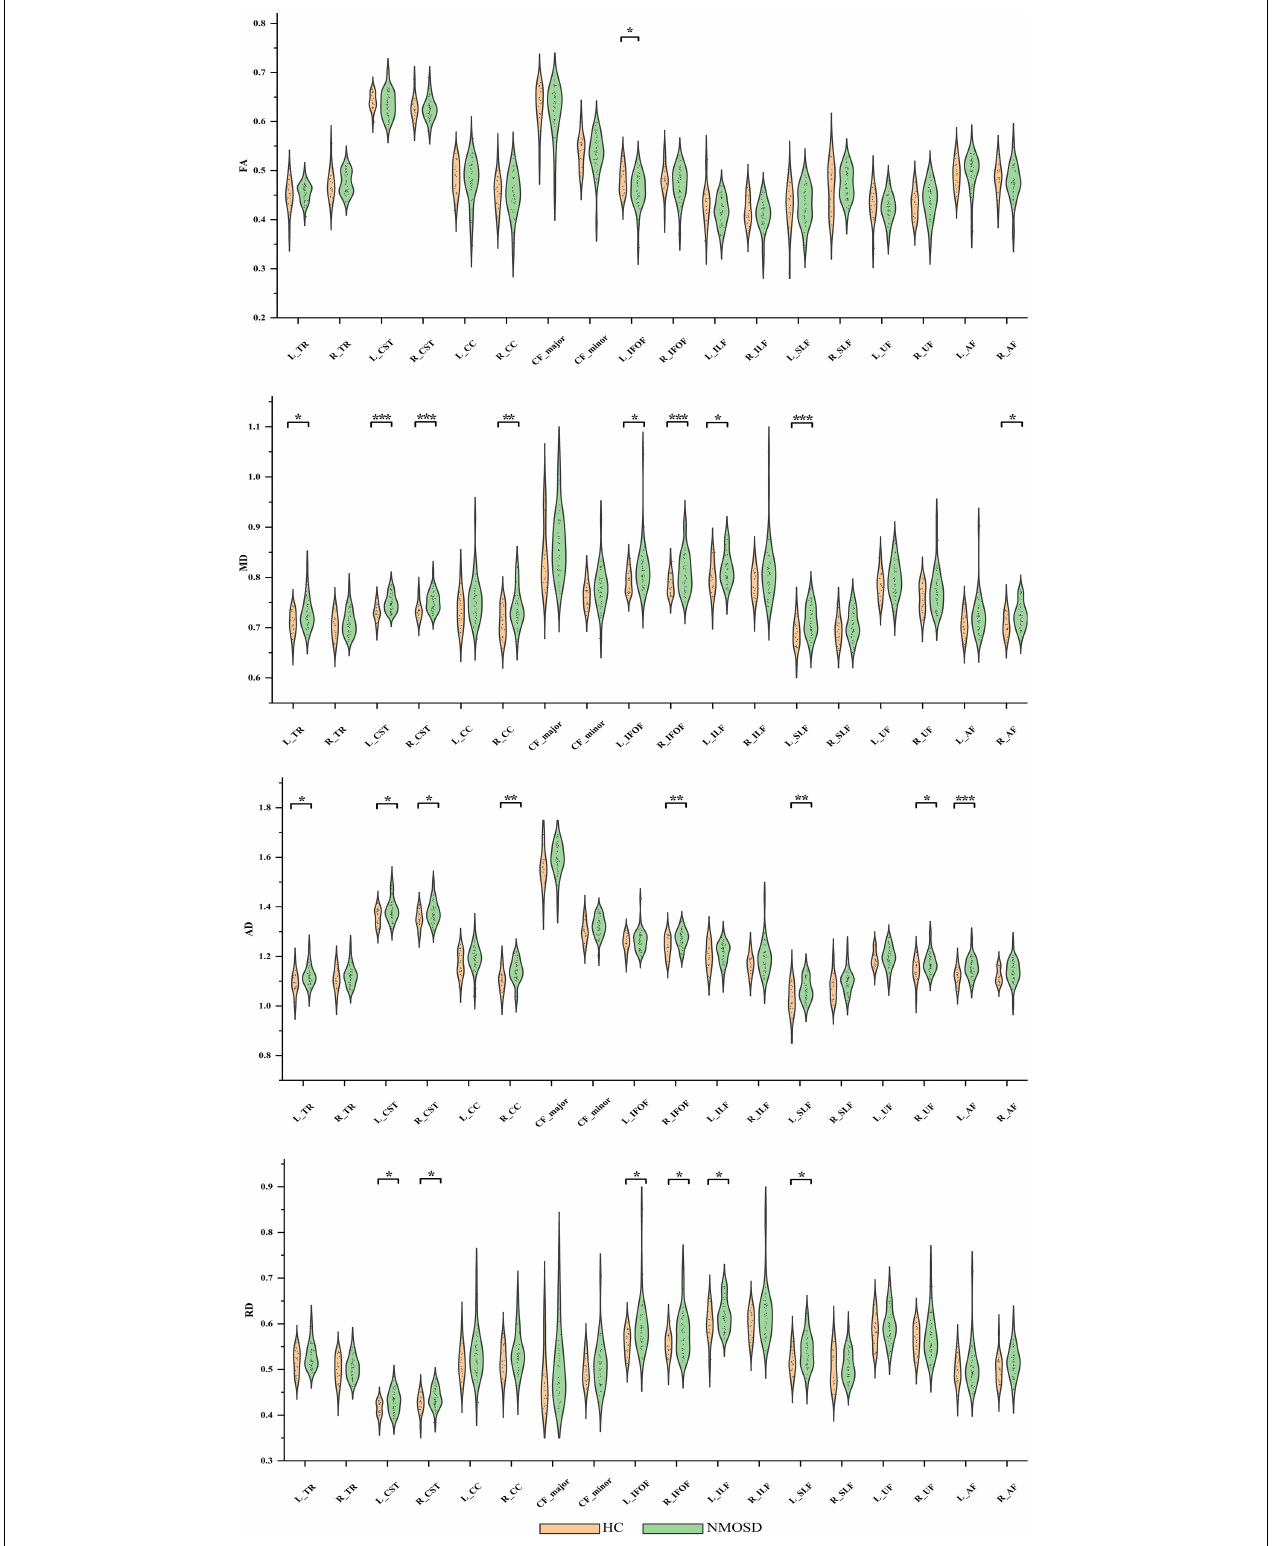
FIGURE 2 | Group differences in entire white matter (WM) fiber tracts of diffusion tensor imaging (DTI) metrics, such as fractional anisotropy (FA), mean diffusion (MD), axial diffusivity (AD), and radial diffusivity (RD). * p < 0.05, ** p < 0.01, *** p < 0.001. NMOSD, neuromyelitis optica spectrum disorder; HC, healthy controls.